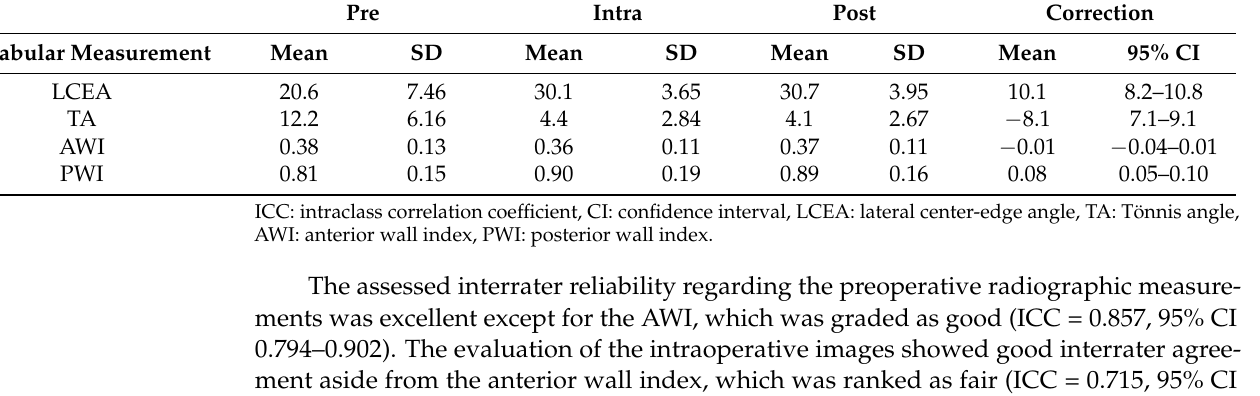
Table 2. Summary of acetabular measurements ( n = 100).